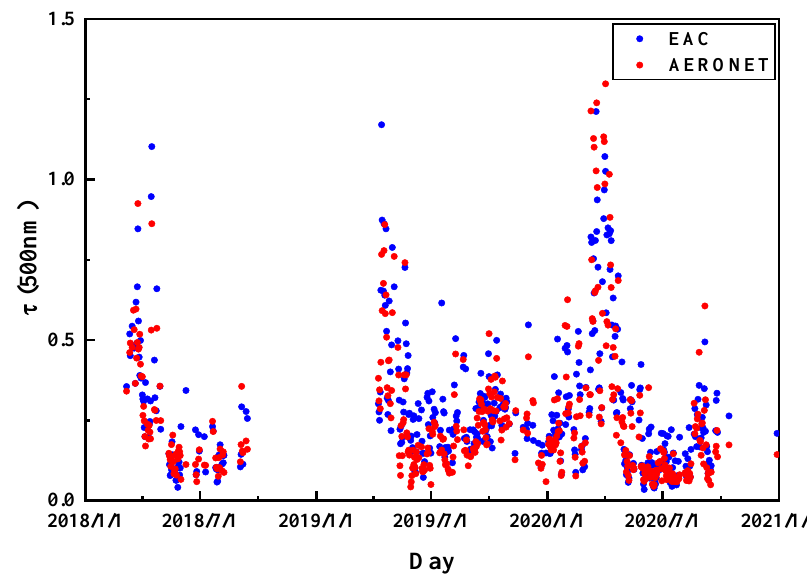
Figure 2. Comparison of τ (500 nm) obtained by AERONET and EAC4 at Dongsha Island.